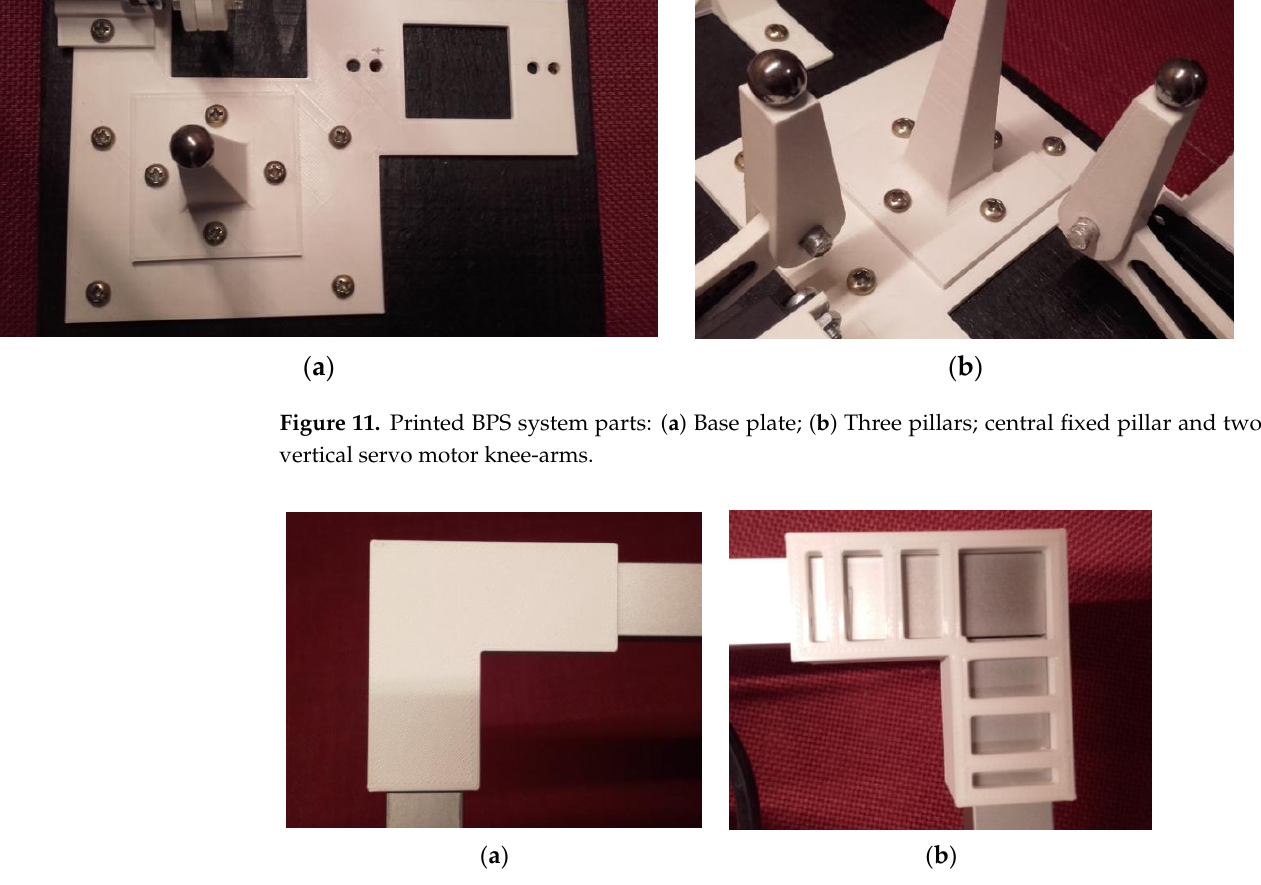
Figure 12. Printed square elbow for the camera holder tubes: ( a ) Front view; ( b ) Rear view.